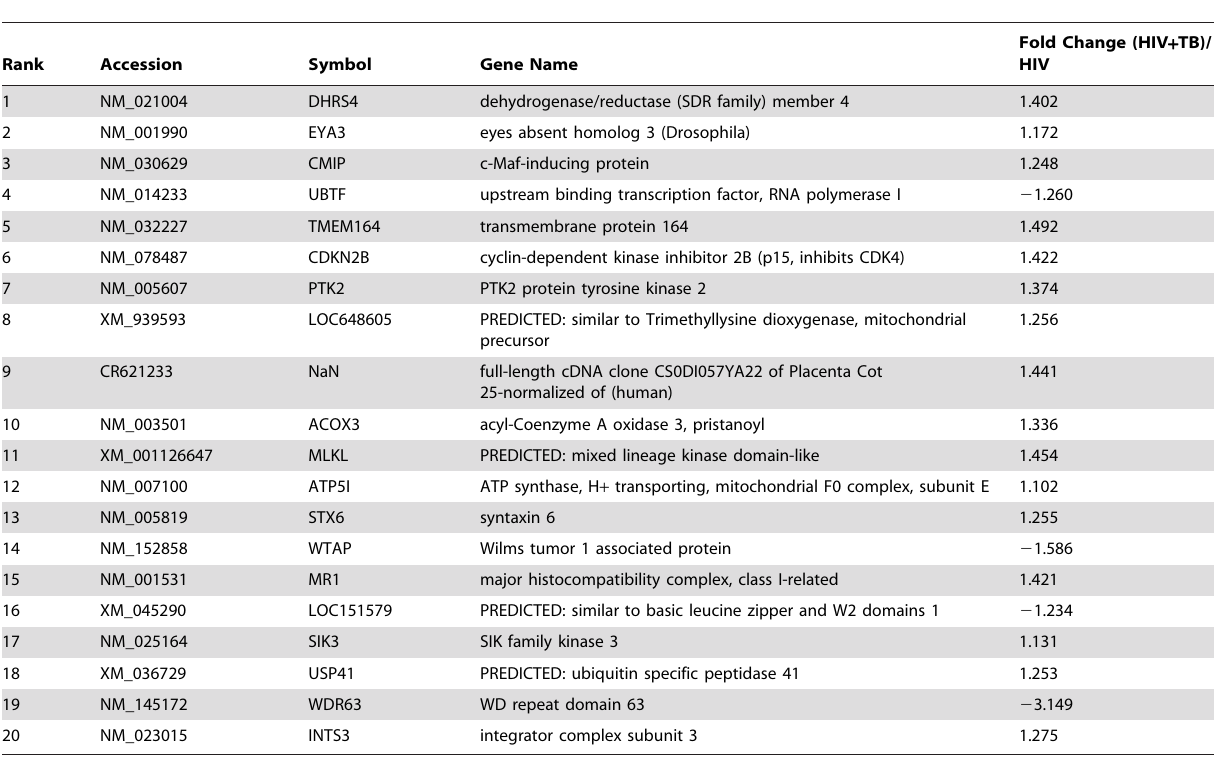
Table 3. Top 20 genes from the 251-gene TB-signature identified using SVM-RFE.